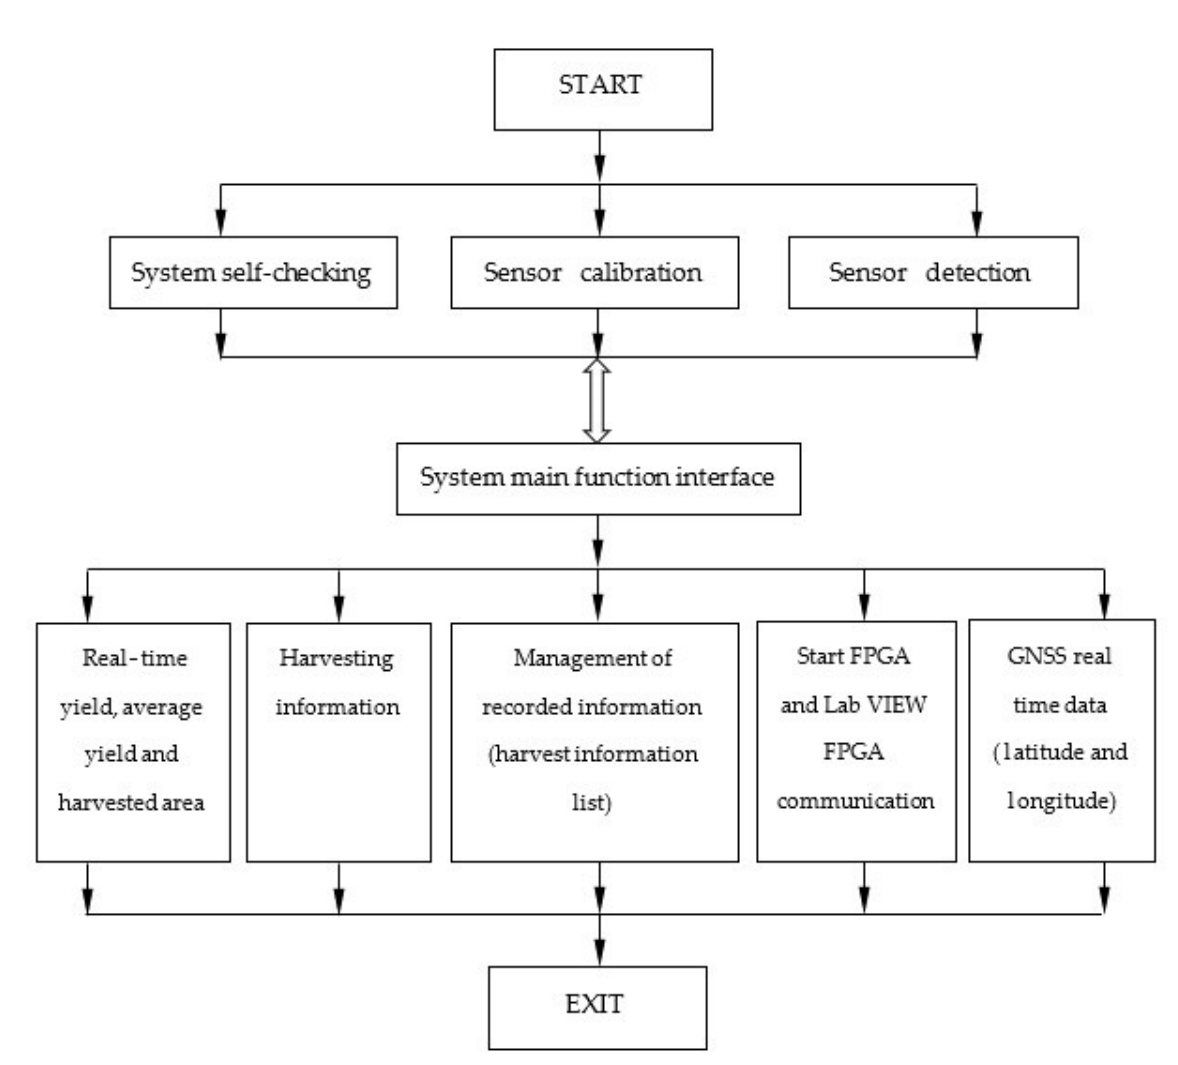
Figure 4. Schematic of the created software.